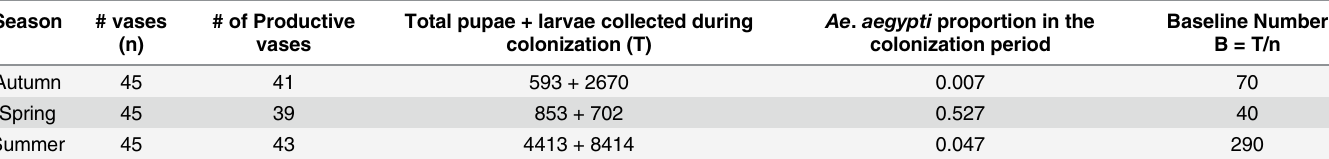
Table 1. Larval and pupal productivity during the colonization period defined the Baseline number for the larval manipulation experiments.